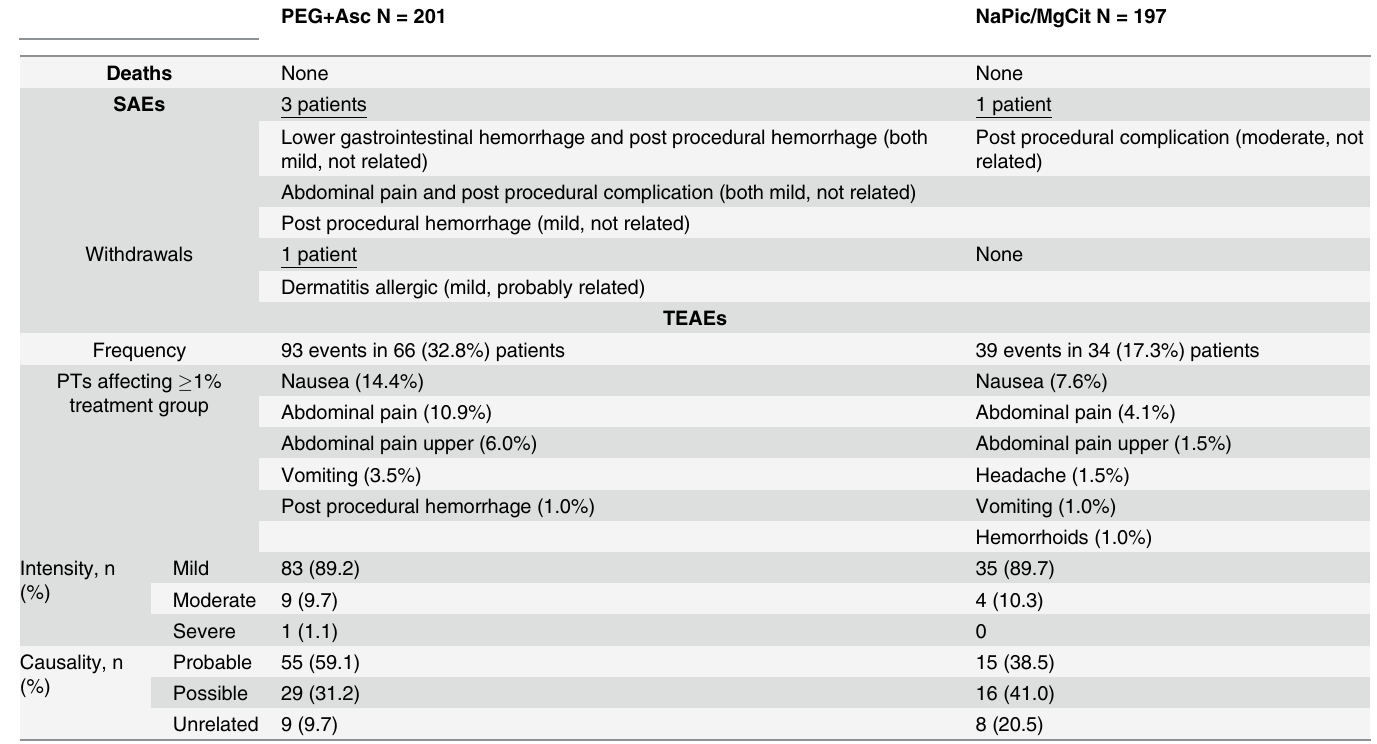
Table 3. Summary of Safety